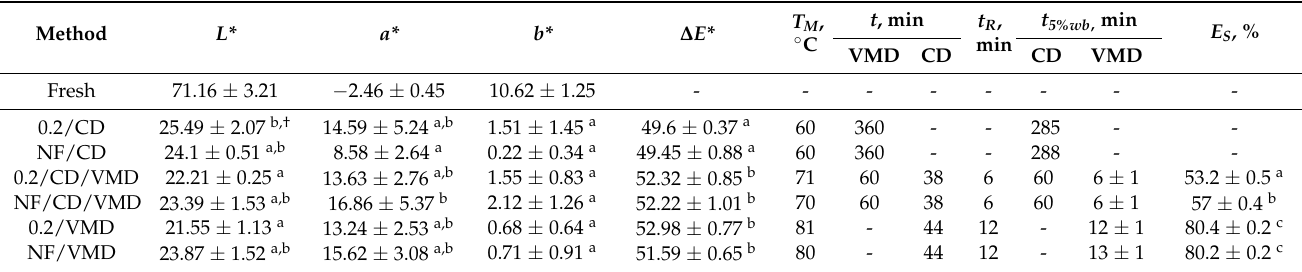
† Values followed by the same letter, within the same column, were not significantly different ( p < 0.05) according to Tukey’s HSD test. NF OD—osmotic dehydration in non-filtrated osmotic solution; 0.2 OD—osmotic dehydration in filtrated (0.2 µ m) osmotic solution; CD—convective drying; VMD—vacuum-microwave